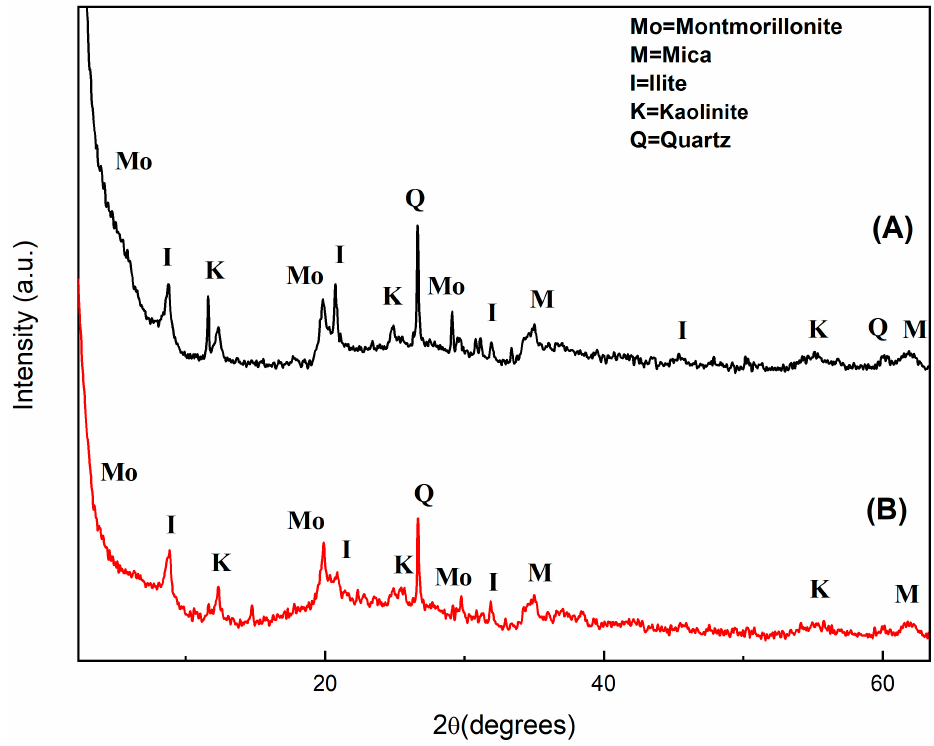
ff ractograms of clay before ( A ) and after ( B ) palm oil Figure 1. X-ray diffractograms of clay before ( A ) and after ( B ) palm oil bleaching. Figure 1. X-ray di